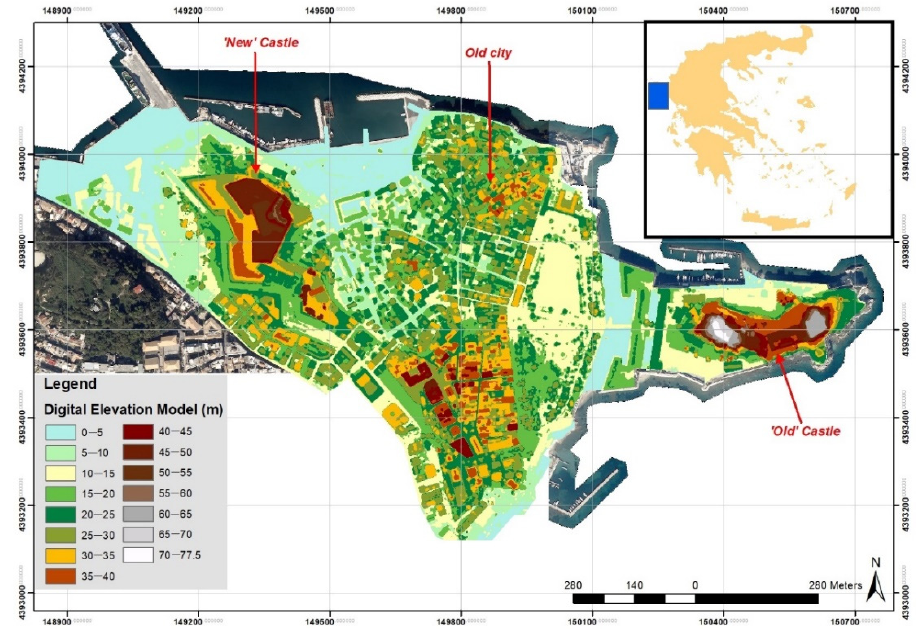
Figure 1. Topographic map of Corfu Old Town and the castles (coordinate system of the map is GGRS87 (Greek Geodetic Reference System, the center of the study area in WGS84 is: Lat.:39.6240, Long.: 19.9218).